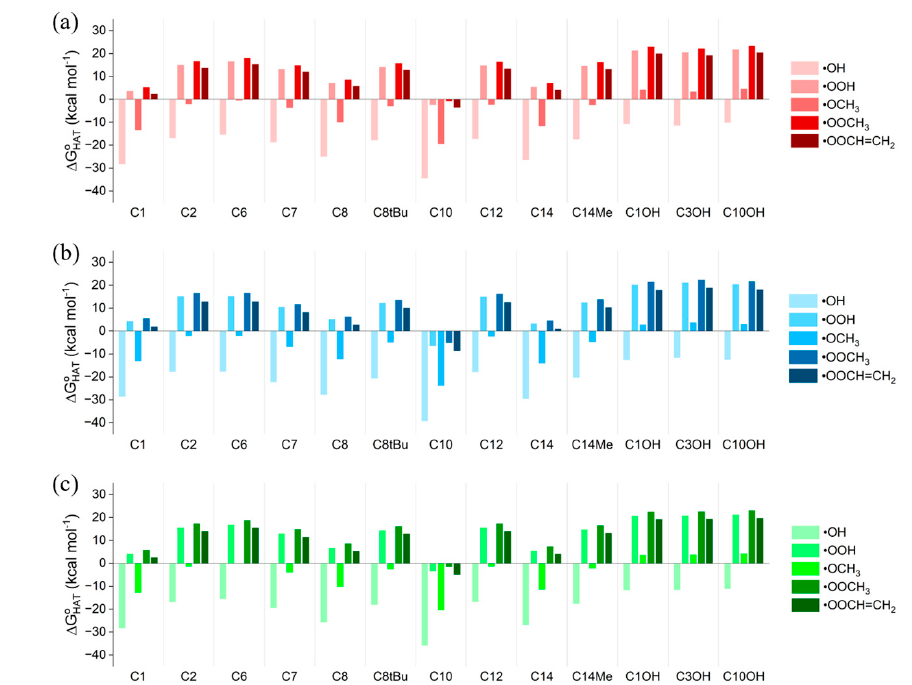
Figure 1 . Gibbs free reaction energies ( ∆𝐺 (cid:3009)(cid:3002)(cid:3021)(cid:3042) ) computed in ( a ) gas phase, ( b ) water and ( c )